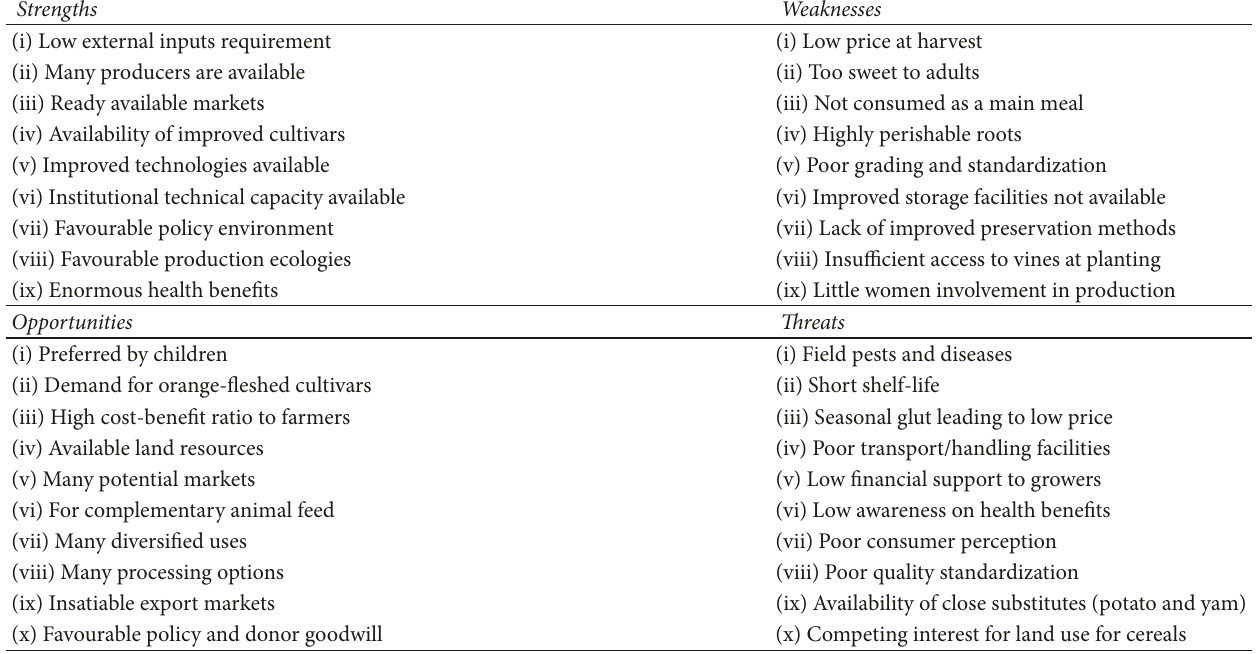
Table 8: SWOT analysis of the sweet potato value chain in Northern